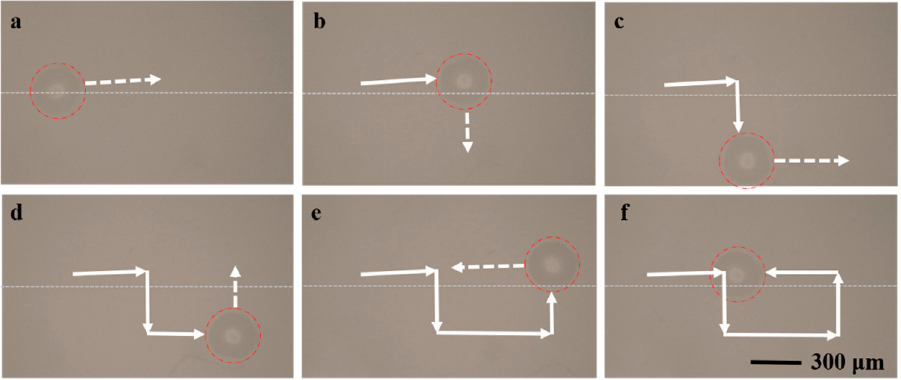
Figure 13. Particle with a diameter of 300 μ m moving along a specific trace with the order ( a – f ).